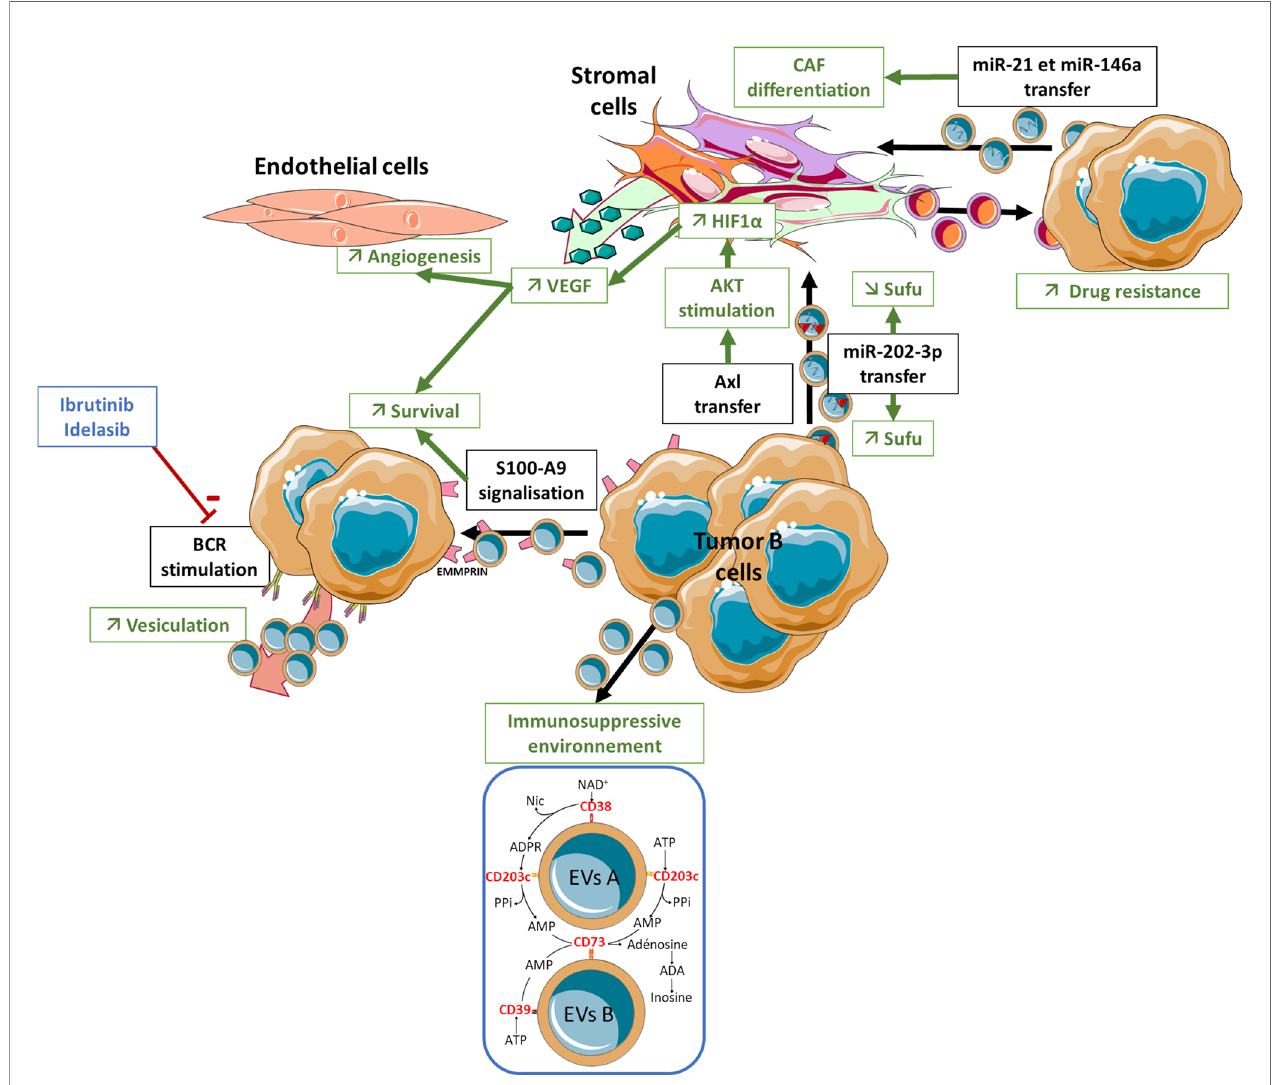
FIGURE 1 | Role of EVs in the lymphoma microenvironment structuration. A bidirectional crosstalk has been reported between CLL and FL tumor B-cells and stromal cells via EVs that can give rise to a highly organized pro-tumor niche. ANGPT, Angiopoietin; BCR, B Cell Receptor; BM, Bone Marrow; CAF, Cancer Associated Fibroblast; EVs, Extracellular Vesicles; TGF, Transforming Growth Factor- b ; VEGF, Vascular Endothelial Growth